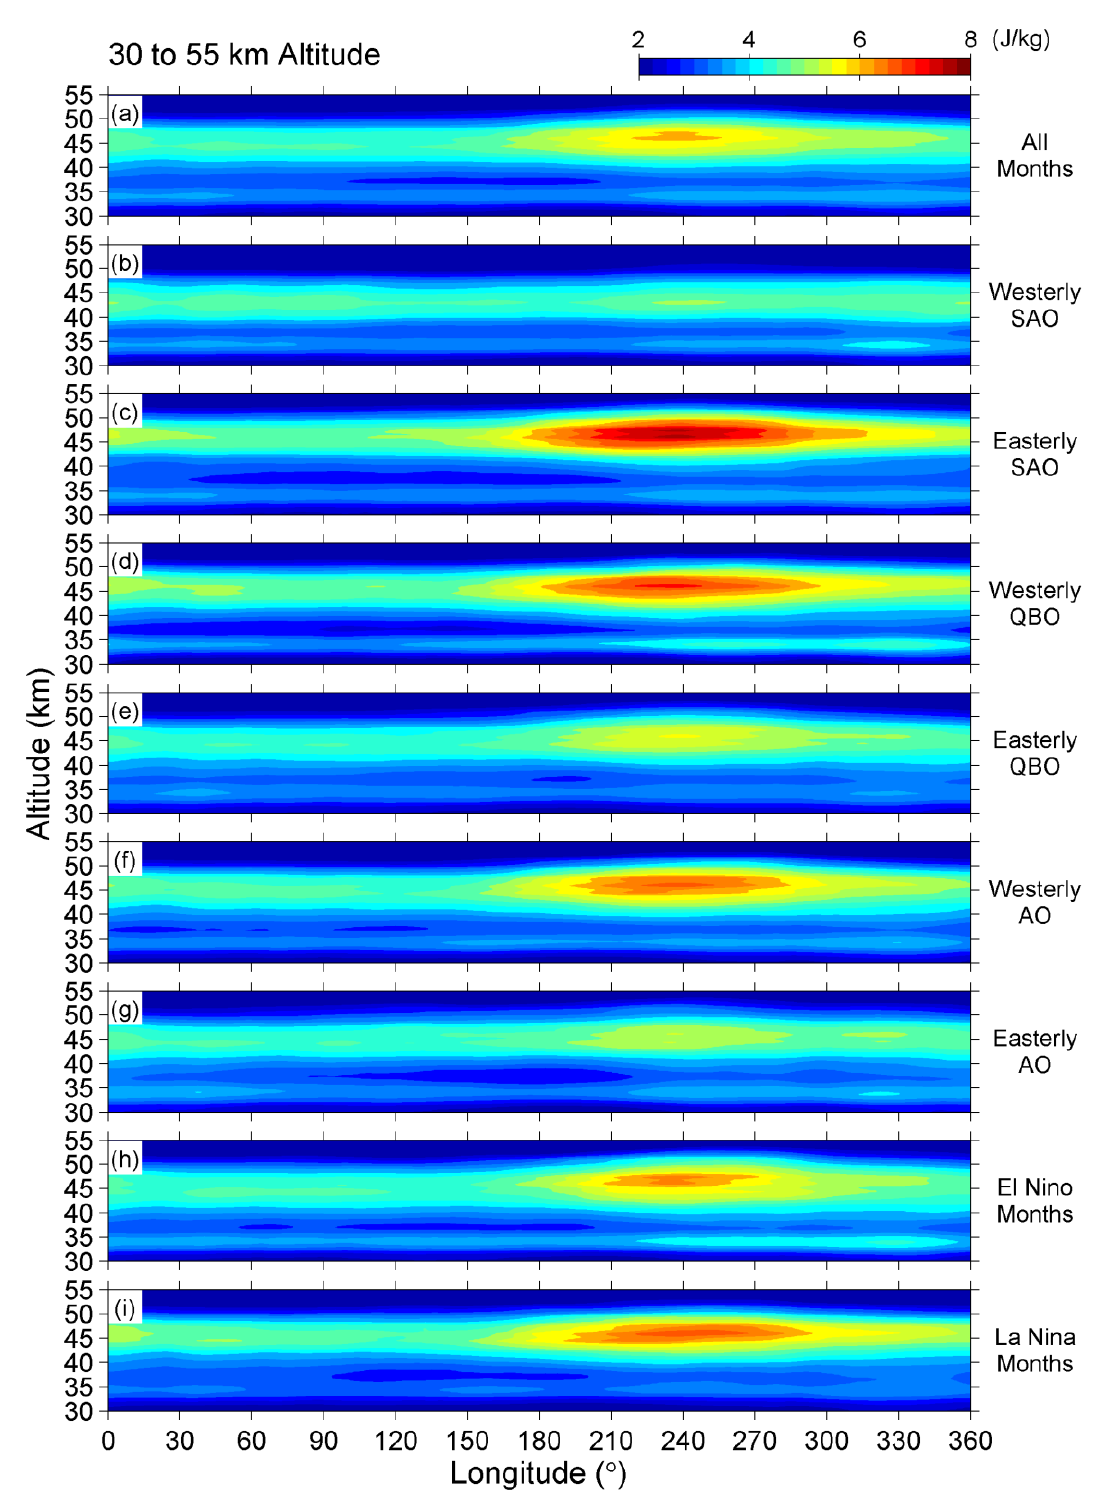
Figure 8. Same as Figure 7, but showing the values at 30–55 km altitude with a different color axis scaling.